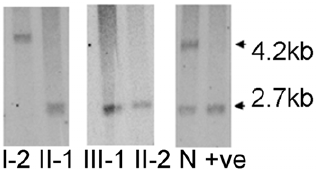
Figure 2. Southern blotting examining methylation at a Not1 site within KvDMR. The methylated maternal allele is at 4.2 kb and the unmethylated paternal allele is at 2.7 kb. Loss of the methylated maternal allele is shown for the affected individuals, II-1, II-2 and III-1. The methylated maternal allele is retained in I-2 and the unmethylated paternal allele is lost. Control DNA is represented by N and a positive control with loss of maternal allele methylation is in the adjacent lane.